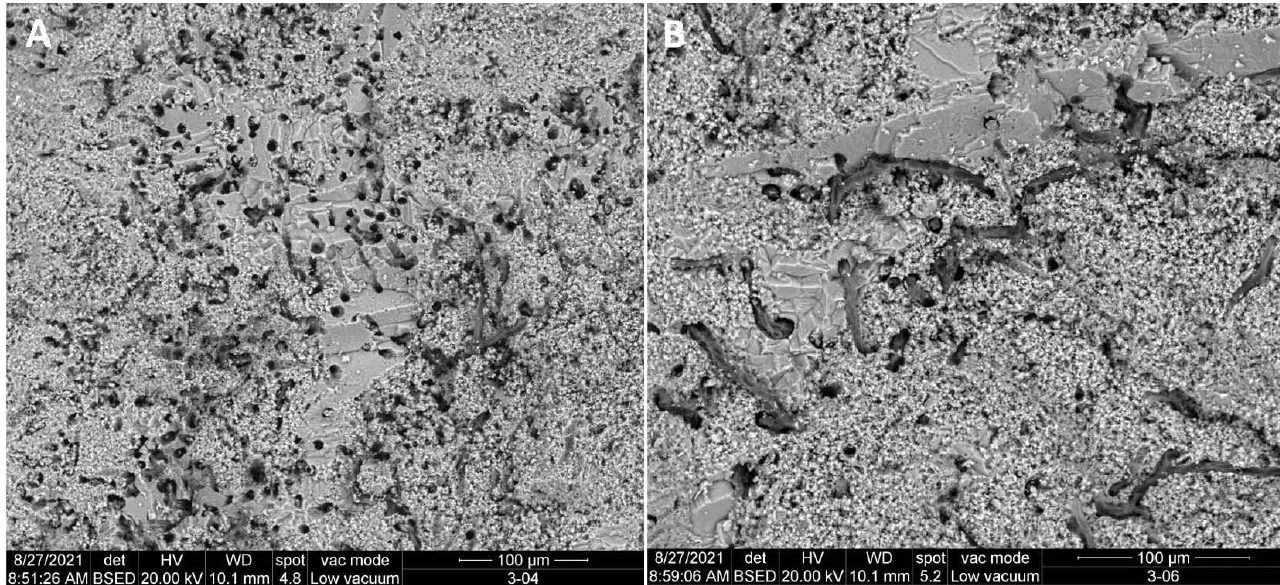
Figure 6. SEM micrographs showing biological weathering features on the limestone surface, Cross of the Inquisition. ( A ) Pits generally show a cylindrical morphology, a diameter between 2 and 10 µm and are not interconnected, although transitions patterns to interconnected pits can also be observed. ( B ) Channels produced by the action of filamentous microbes on the limestone surface.